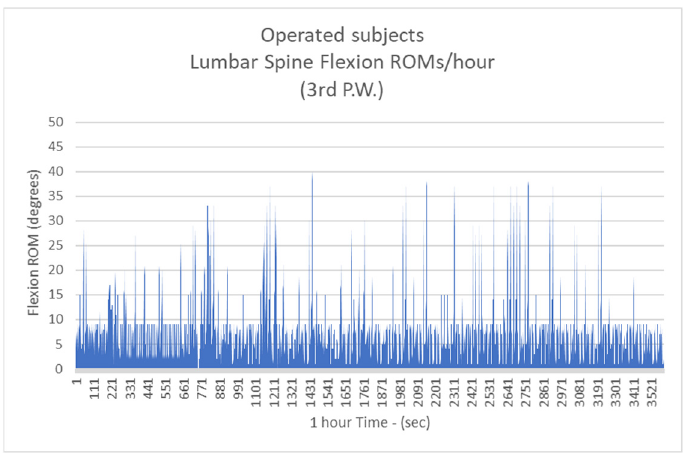
Figure 7. The number of more than 10 degrees of Lumbar Spine Flexions (LSFs) per hour for operated subjects at the 3rd postoperative week.